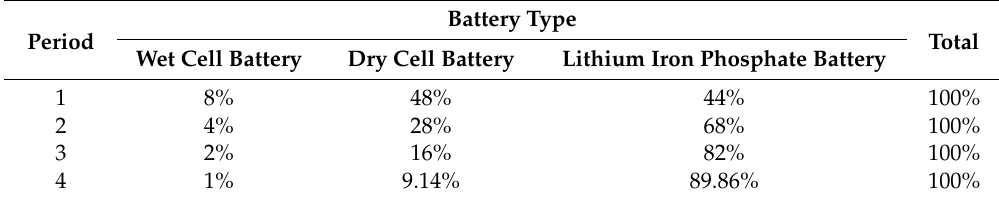
Table 4. Market Share Prediction.